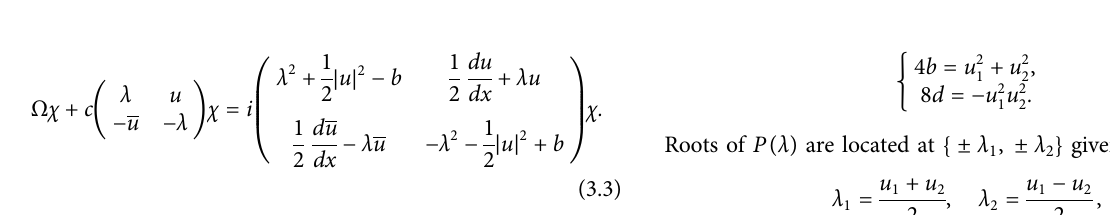
FIGURE 1 | Amplitude-normalized double-periodic waves Eq. 2.15 (left) and Eq. 2.16 (right) with k (cid:2) 0 .